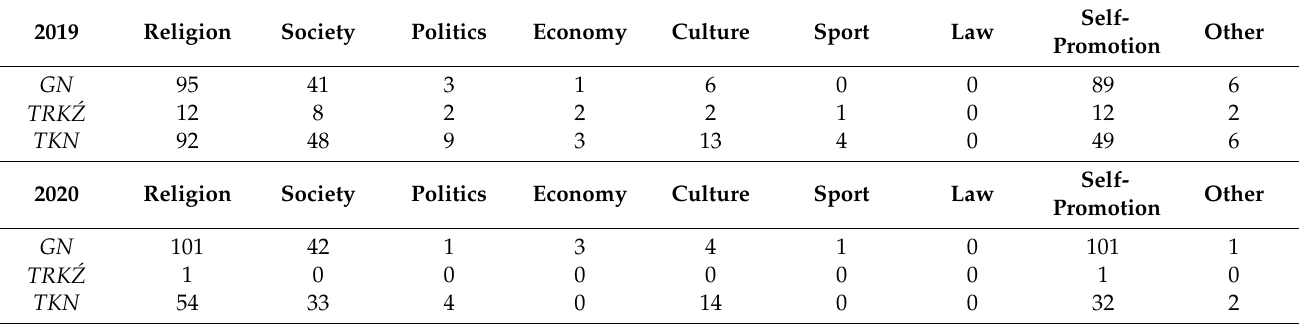
Table 9. Topics of posts on the YouTube profiles of the selected Catholic weeklies